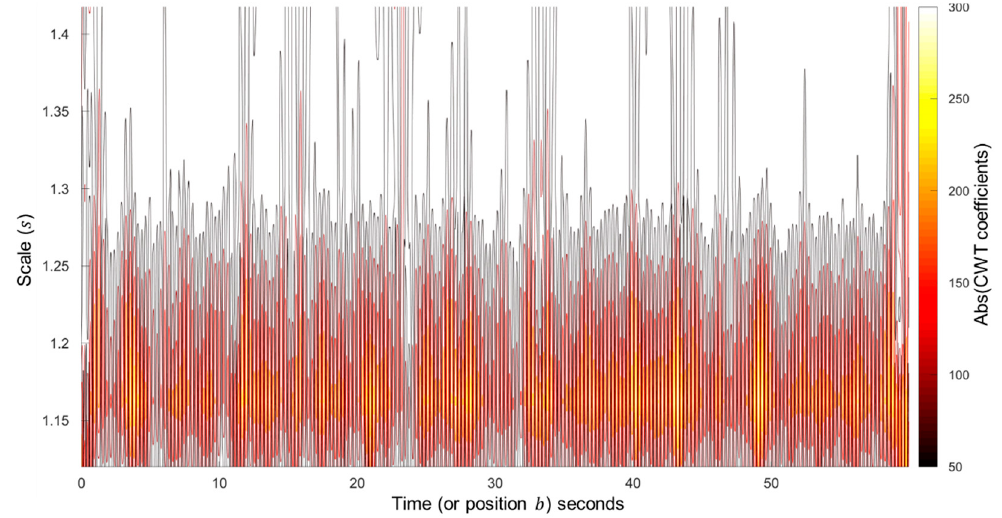
Figure 7. The scalogram of the chosen set of scales ( s = 2 a ) shows the scales dominated by the energy (high absolute CWT coefficients) from the cardiogenic pulse signal, calculated using the fourth order DOG wavelet.